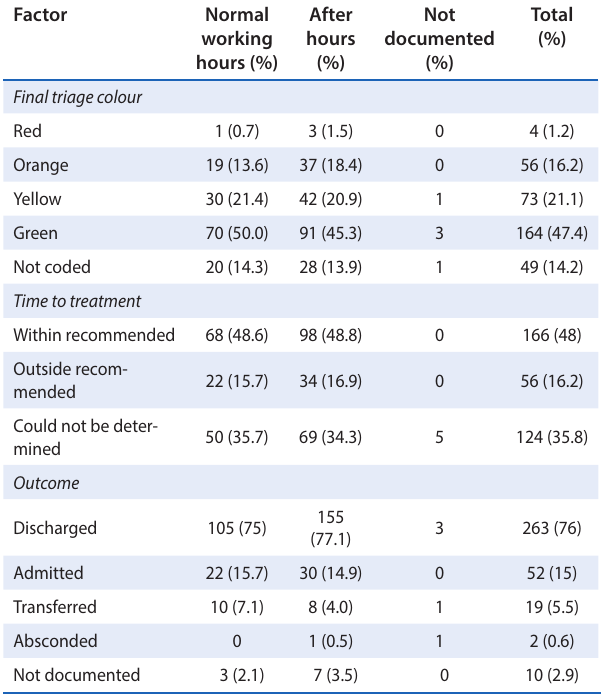
Note: Percentages shown in parentheses are of patients seen based on the time of